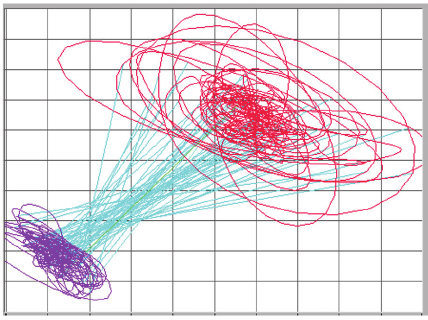
fluid-induced vibration can be confirmed in this